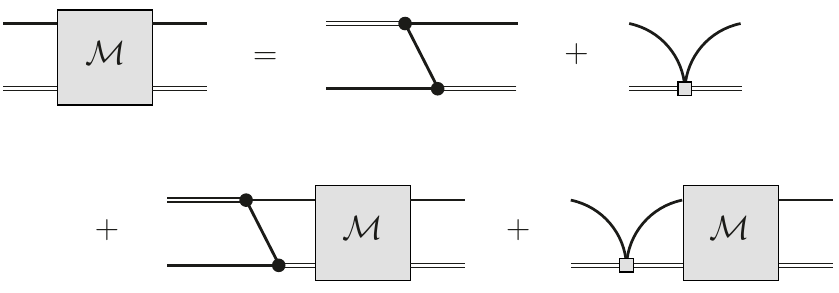
Figure 3 . Faddeev equation for the particle-dimer scattering